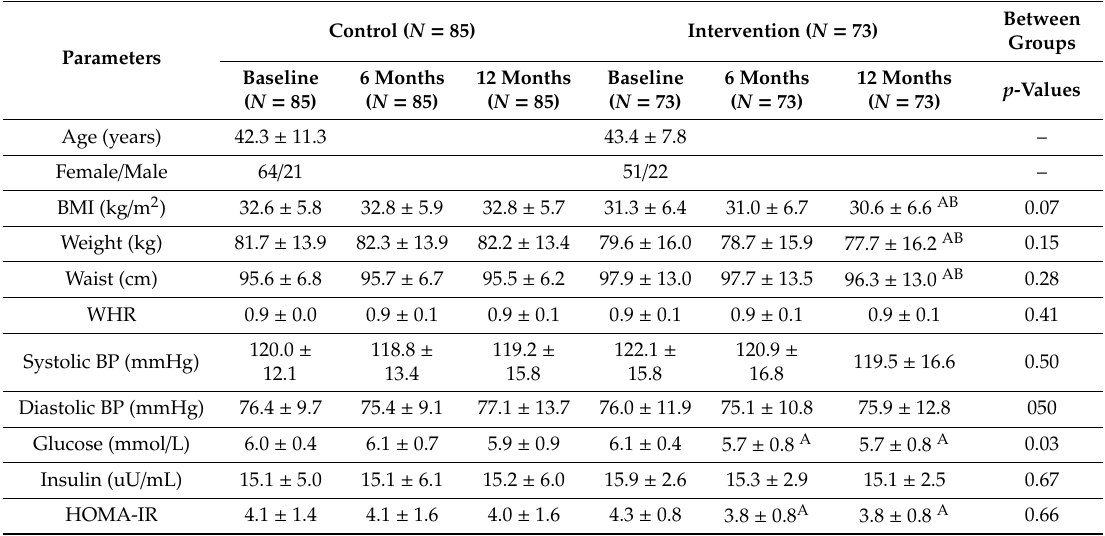
Table 3. Descriptive statistics according to groups and time.